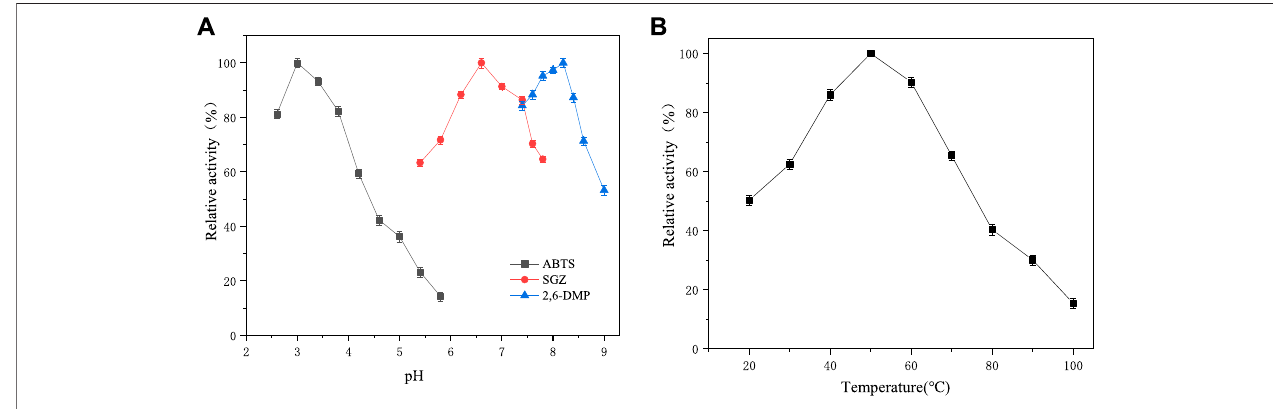
FIGURE8| Effect ofpH and temperature on intracellular laccase activity of Bacillus subtilis TR-03. (A) pH, withABTS, SGZ and 2,6-DMP as substrate at 30 ° C; (B) temperature, with ABTS as the substrate at pH 3.0.